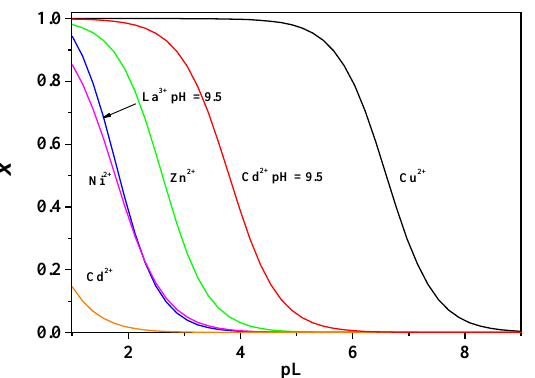
Figure 15. Sequestering diagram for some metal/dopamine systems, at I = 0.15 mol dm −3 , T = 298.15 K and pH = 7.4.pL 0.5 : Cd 2+ = 0.23; Ni 2+ = 1.77; Zn 2+ = 2.61; Cu 2+ = 6.60 (pH = 9.5: La 3+ = 1.85; Cd 2+ = 3.80). 0.15 mol dm −3 in NaCl aqueous solutions, T = 298.15 K and pH = 7.4; the following seques-